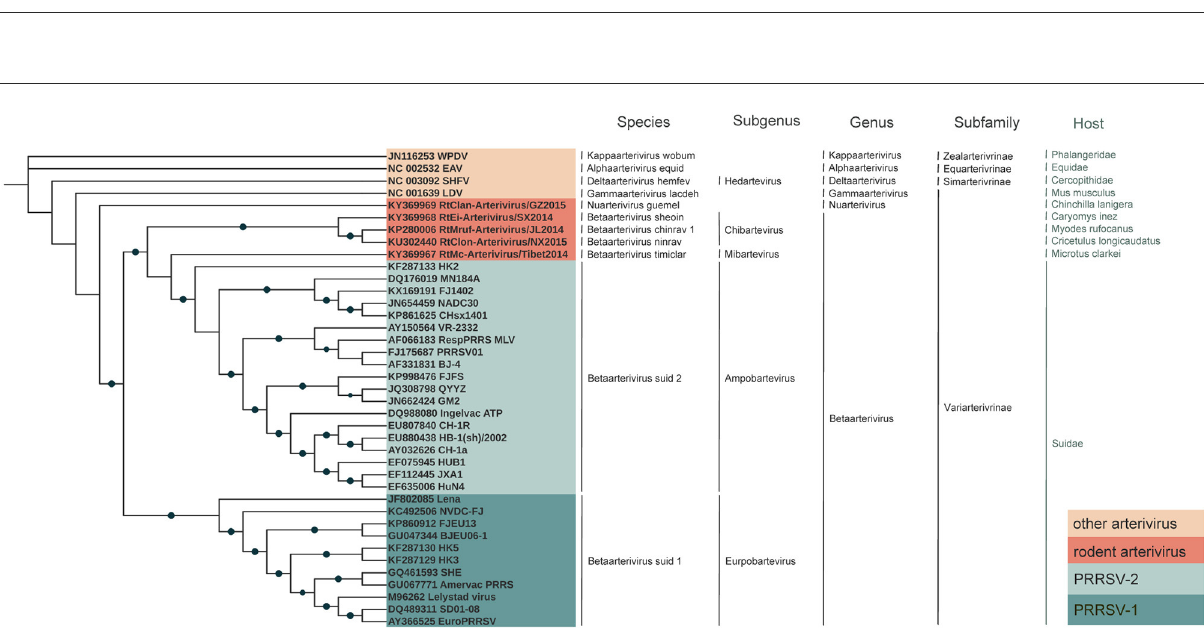
the full genome or RdRp, Hel, 3CLpro, and N genes. In the full genome-based phylogenetic tree, RtMc-Arterivirus/Tibet2014, RtEi-Arterivirus/SX2014, RtMruf-Arterivirus/JL2014, and RtClon- Arterivirus/NX2015 clustered together with PRRSV-2 and were closer than PRRSV-1, while RtClan-Arterivirus/GZ2015 was outside these strains (Figure